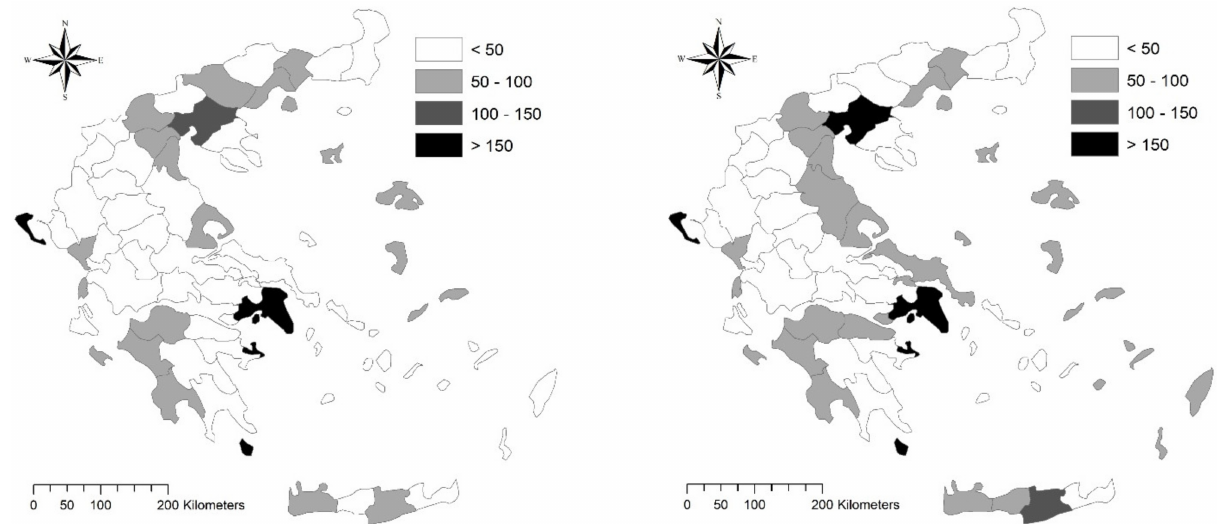
Figure 2. Map of Greek prefectures based on ELSTAT shapefiles, indicating population density (inhabitants/km 2 ) in 2000 ( left ) and 2020 ( right ).